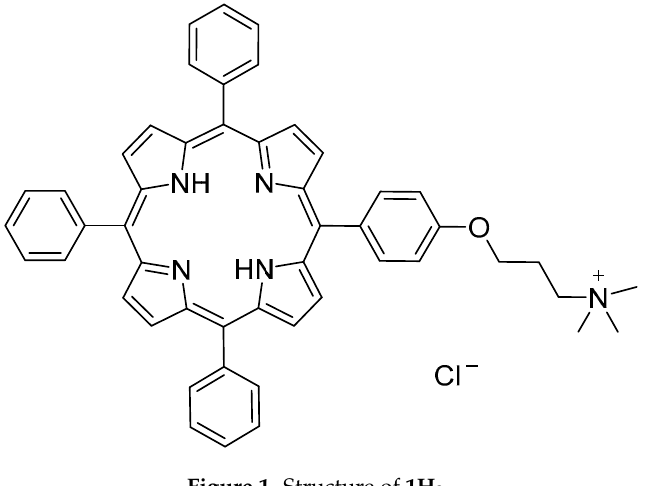
Figure 1. Structure of 1H 2 .